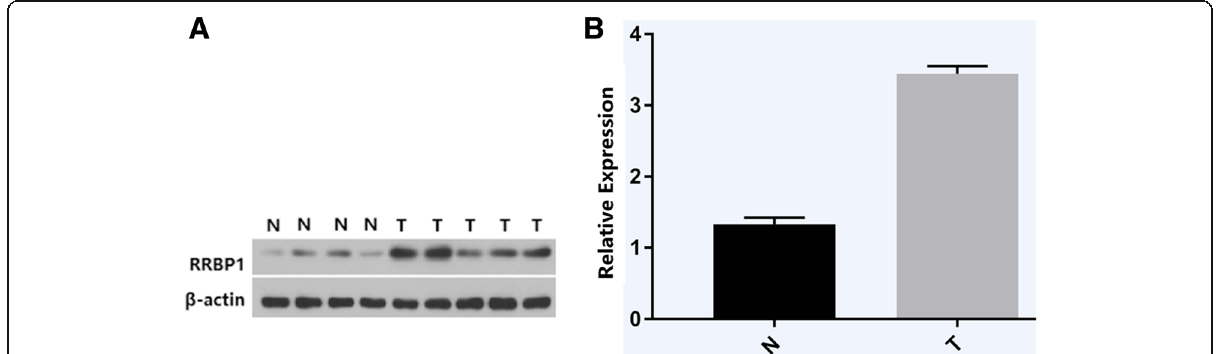
Fig. 1 a , Representative protein samples obtained from frozen normal endometrial tissues (N) and endometrial endometrioid adenocarcinoma tissues (T) were analyzed by Western blot analysis. The levels of β -actin were used as an internal control; b , Histogram of pooled data from N ( n = 19) and ECs ( n = 35). RRBP1 expression was elevated in ECs compared with N. The data are presented as mean ± s. d. ( P < 0.05)